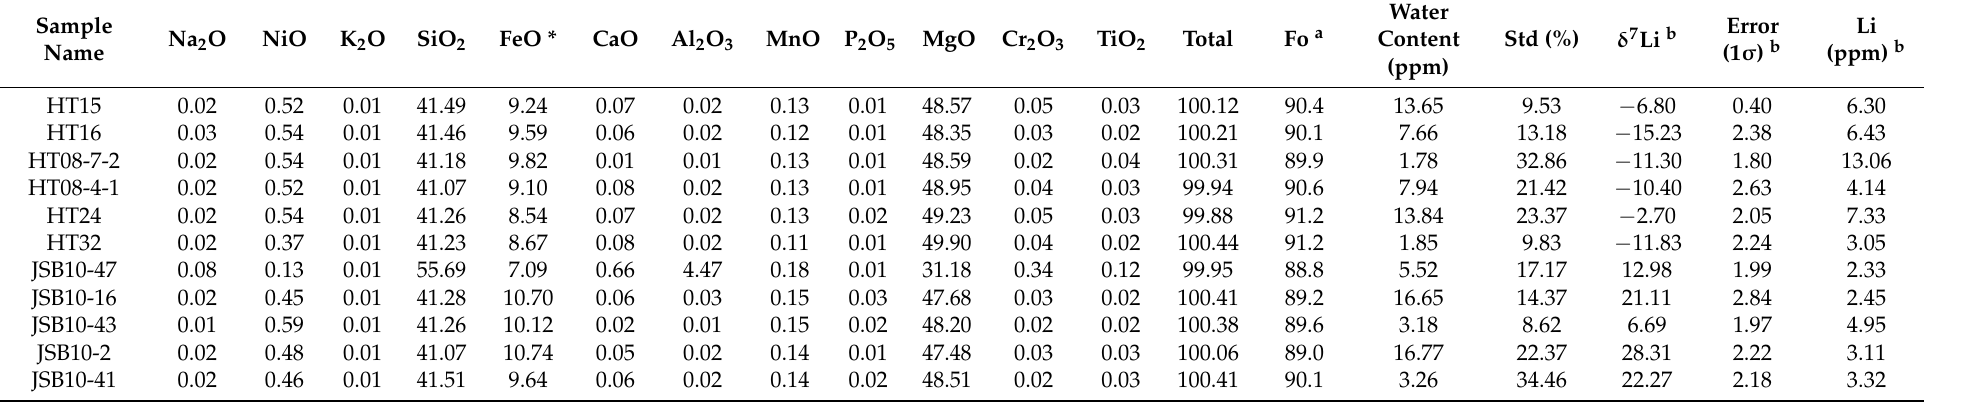
Table 1. Summary of major elements, water content, Li content, and δ 7